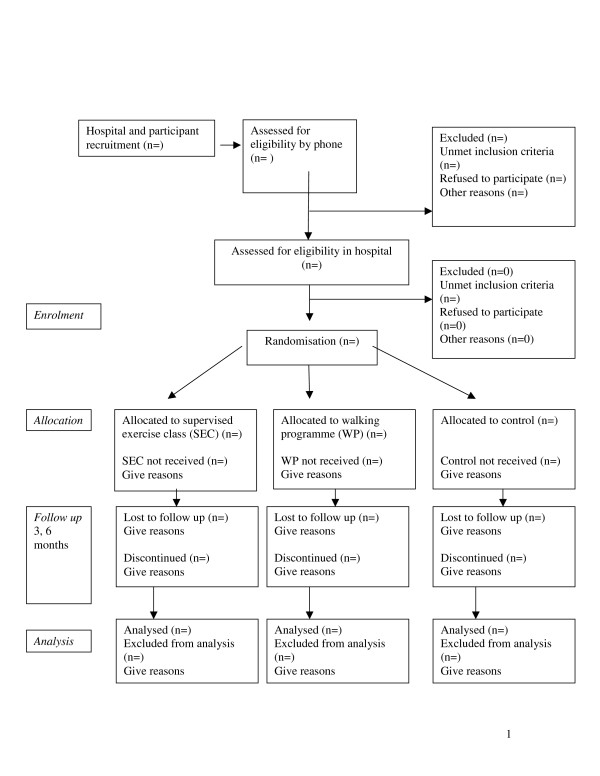
Participant flow through the RCT (based on CONSORT statement).